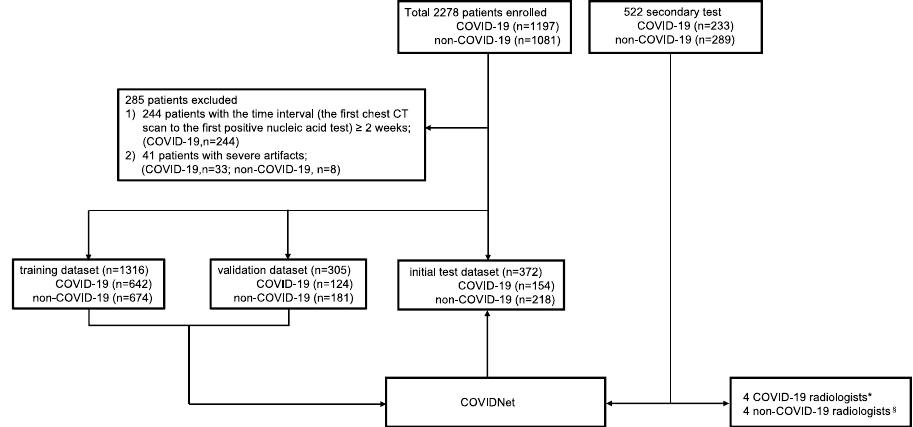
Figure 1. Flow diagram illustrating the division of model development data into training, validation, initial test, and secondary test on the secondary test dataset. The model development cohort consisted of 1197 COVID-19 patients and 1,081 non-COVID-19 patients. The secondary test cohort enrolled 233 COVID-19 patients and 289 non-COVID-19 patients. 285 patients were excluded due to ≥ 2 weeks interval of the first CT scan to the first positive nucleic acid test (244 patients), and severe artifacts (41 patients). The model development cohort was then divided into a training dataset (1316 patients), a validation dataset (305 patients), and an initial test dataset (372 patients) to train and fine-tune COVIDNet. A secondary test was then performed to test the model generalizability by comparing the diagnostic performance of COVIDNet and 8 different expert radiologists